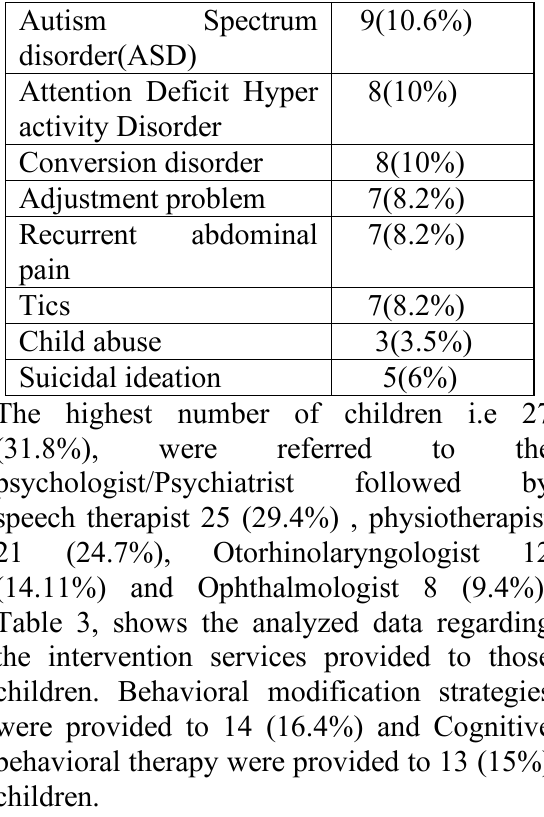
Table 3: Professionals involved in the